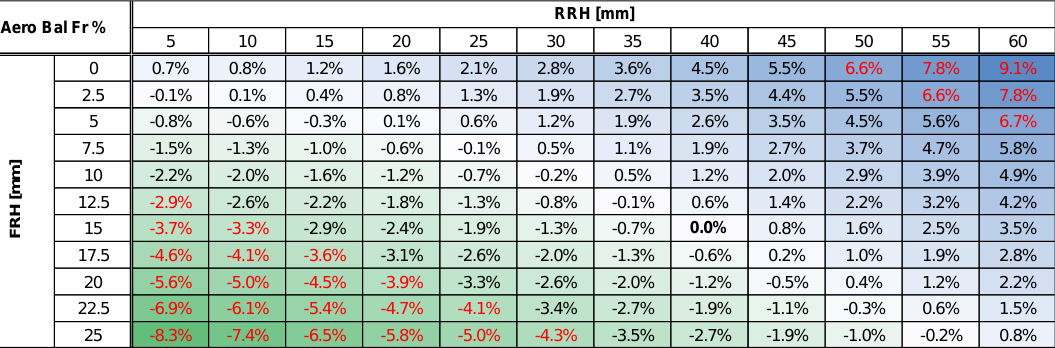
Figure 8. Aero balance A B vs. FRH and RRH. The variation is computed with reference to the average A B within the map domain, corresponding to FRH = 15 mm, RRH = 40 mm for a pitch angle of 0.46° over a wheelbase of 3.12 m. Background colors in this case highlight the trend of the fore/aft downforce distribution or aero balance with reference to the average value: blue is forward, green is rearward.